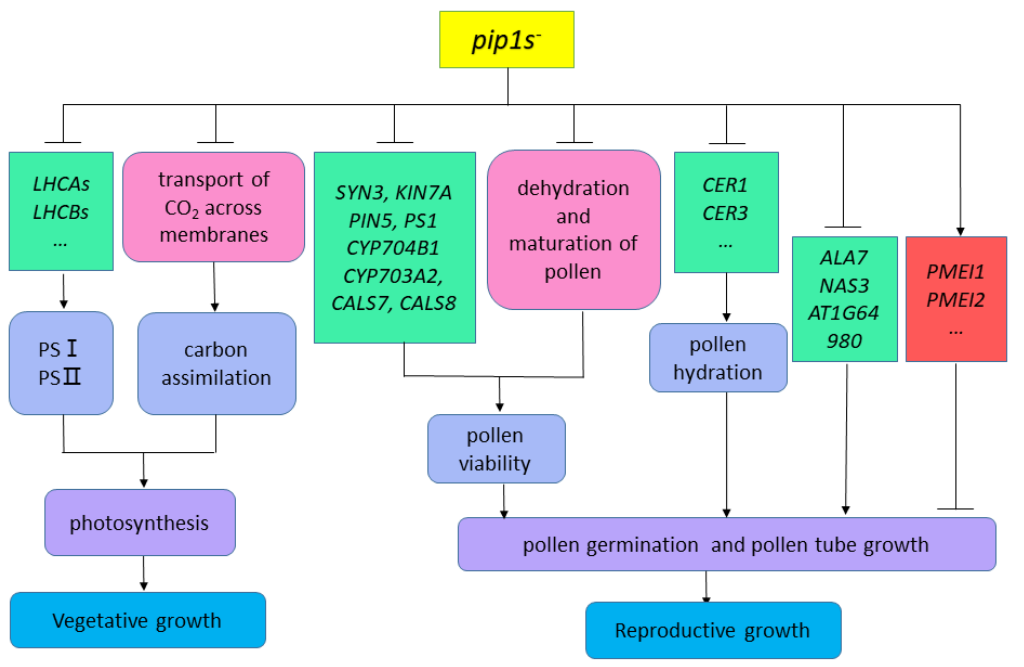
Figure 11. Hypothesis diagram of pip1s - mutants affecting plant vegetative and reproductive growth.